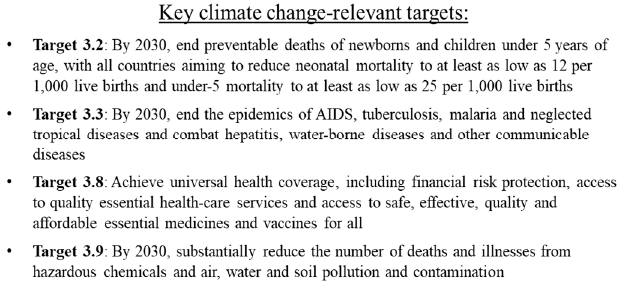
Figure 9. Sustainable Development Goal (SDG) 3 and key climate-relevant targets.